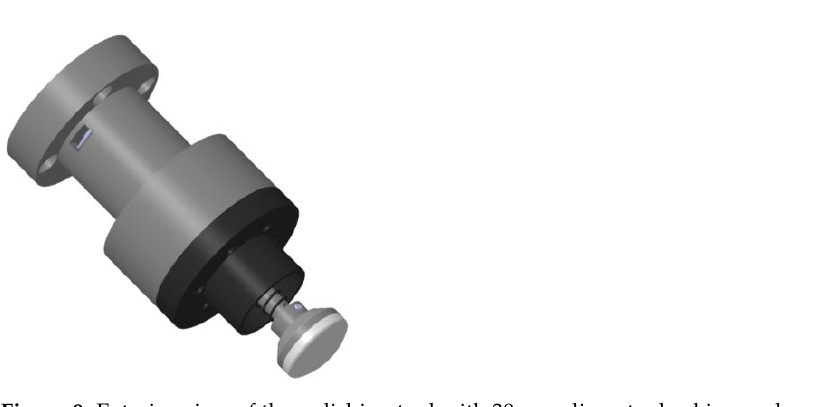
Figure 9. Exterior view of the polishing tool with 30 mm diameter backing pad.